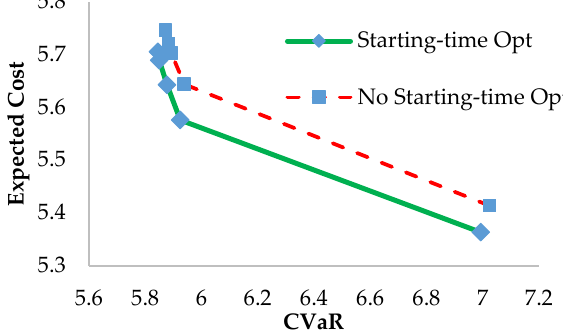
Figure 5. E ffi cient frontier for case b (million € ). Figure 5. Efficient frontier for case b (million €). Table 9. Stating time optimization vs.